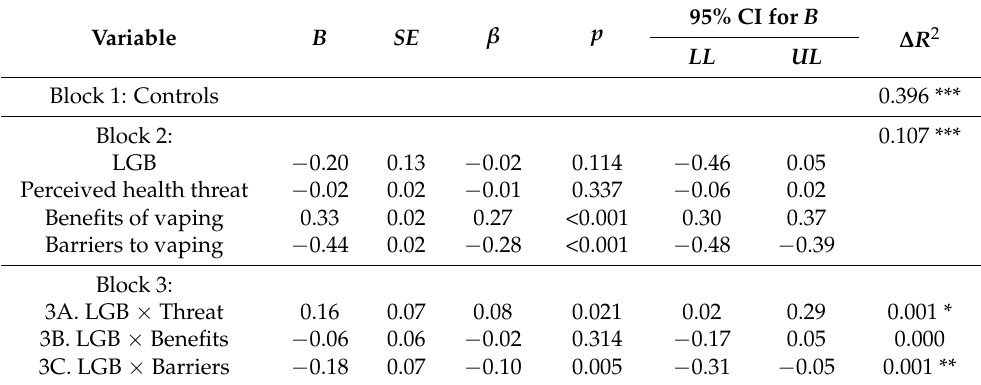
Table 4. Hierarchical Regression Analyses Predicting Intentions to Vape.